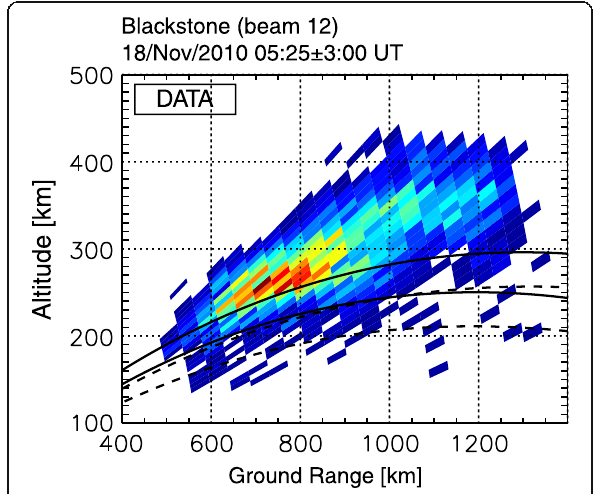
Fig. 18 Observations of the altitude of the irregularities associated with SAIS from beam 12 of the Blackstone radar near local midnight on 18 November 2010. The two solid curves mark the region where the magnetic aspect angle is within 1° of perpendicularity. Reproduced from Fig. 7 of de Larquier et al. (2013)